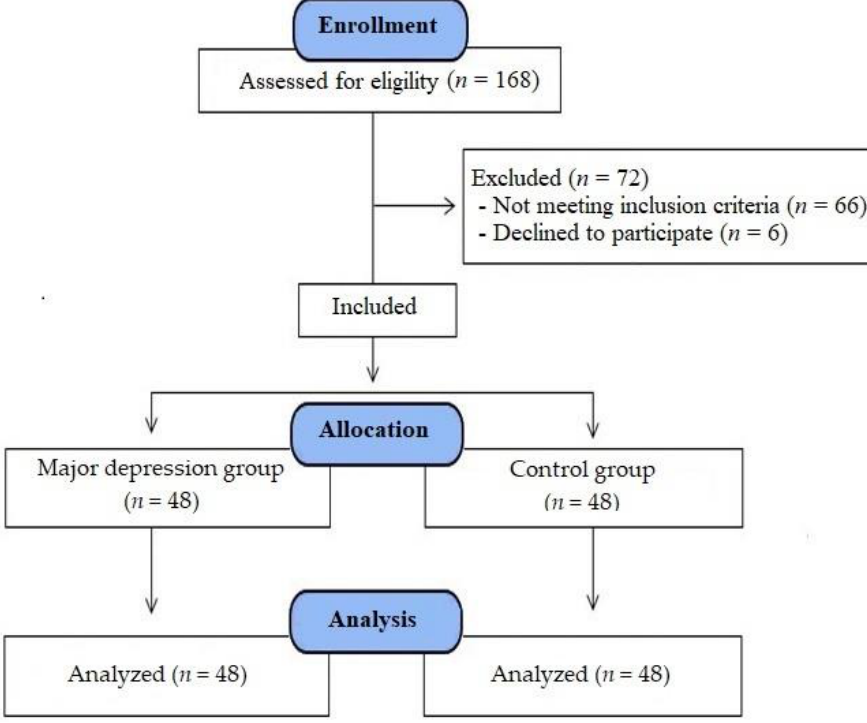
Figure 1. Flow consort chart of the study.